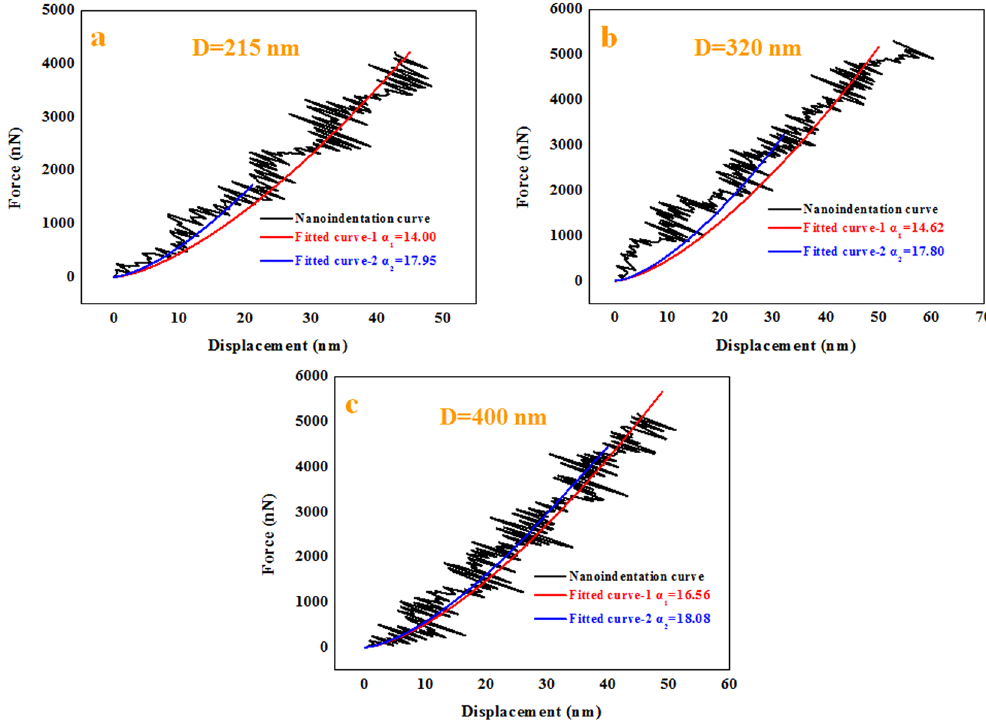
Figure 7. Force-displacement curves for different diameters of the samples extracted from nanoindentation experiments with different fitted curves as the displacement increased. The diameters were ( a ) 215 nm, ( b ) 320 nm and ( c ) 400 nm.